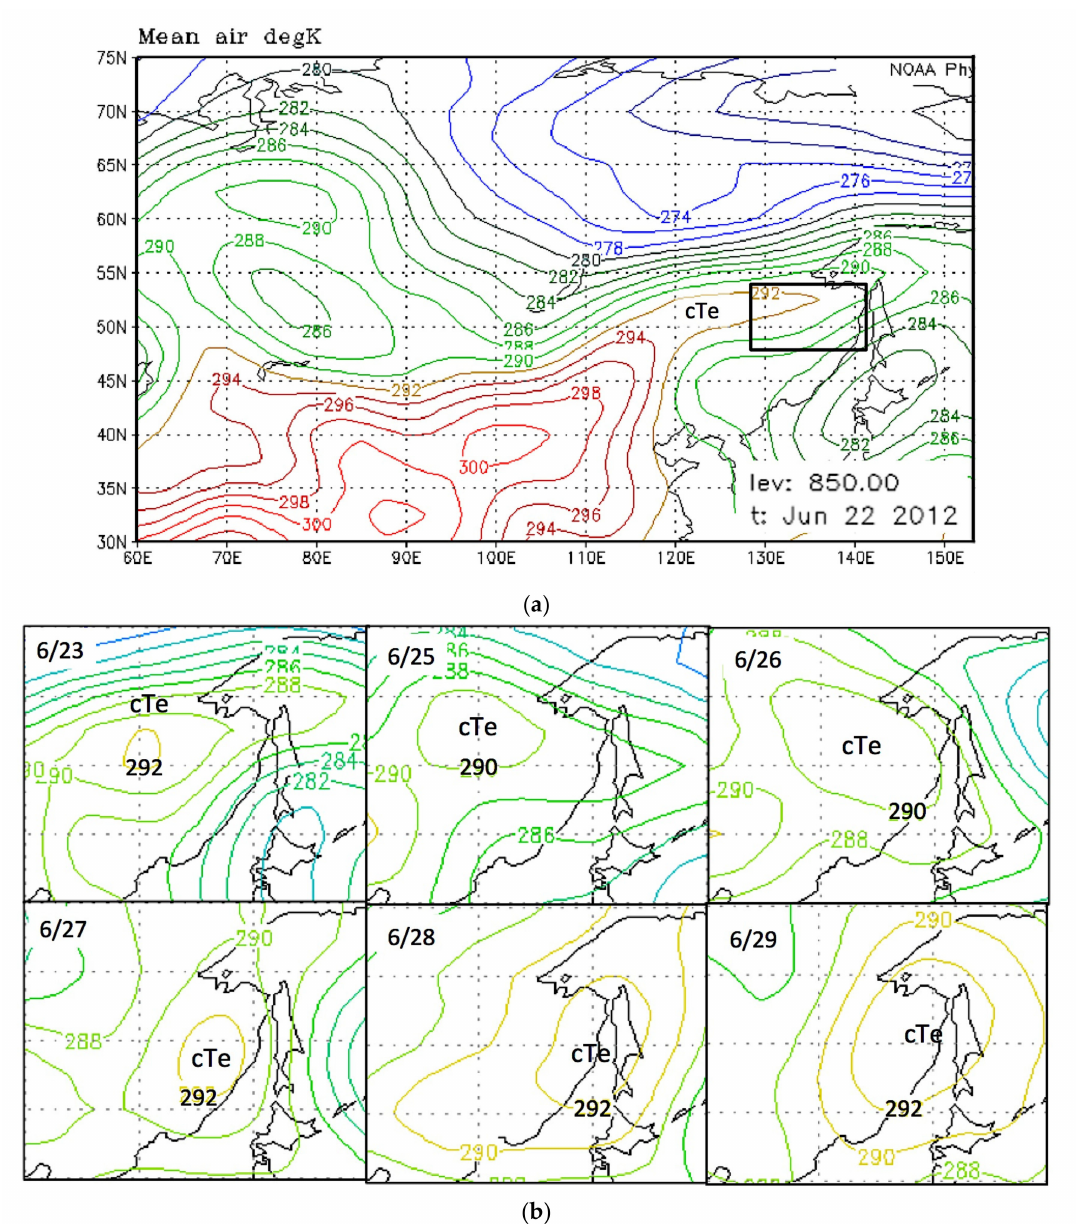
Figure 12. Temperature maps at the middle level (850 hPa) during the (1)29 Jun’12 fire-period (maximum number of daily HSs on June 29 was 2758). ( a ) Temperature ridge formation from the middle latitude (about 40 ◦ N) to the SKK region on 22 June 2012. ( b ) Size and temperature of cTe from 23 June to 29 June (peak HS